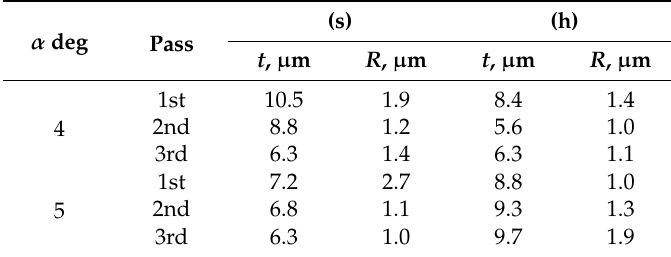
Table 5. Summary of the experimental